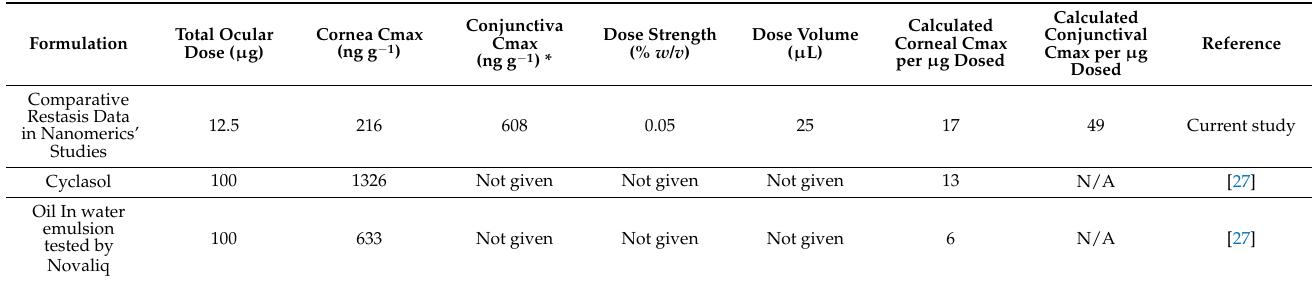
Figure S2: Particle size distribution following the application of increasing high pressure homoge-